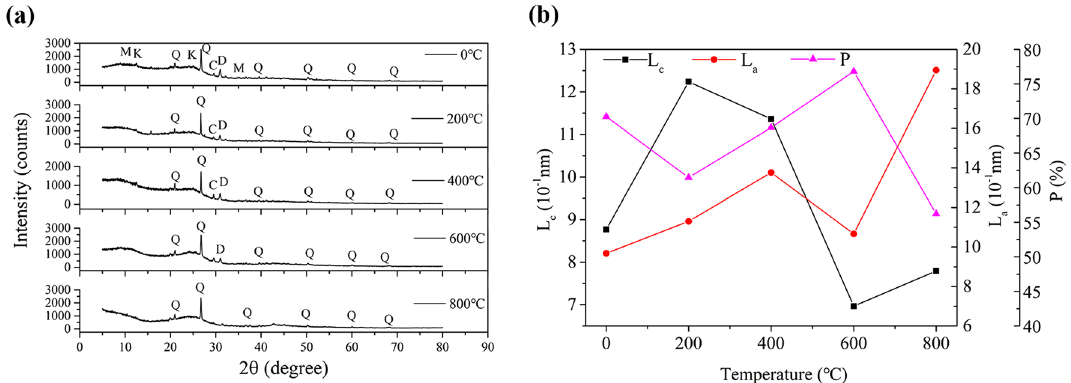
Figure 4. Results from XRD experiments [ a XRD spectrum at different temperatures; b microcrystalline structure parameters (Q–quartz, K– kaolinite, D–dolomite, C–calcite, M–muscovite)]. Coal sample ( ℃ )